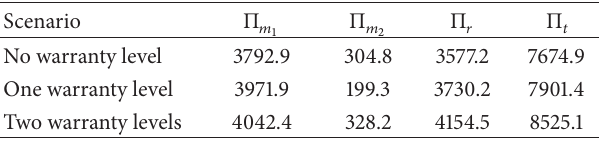
Table 6: Comparison of the maximal profits with and without warranty